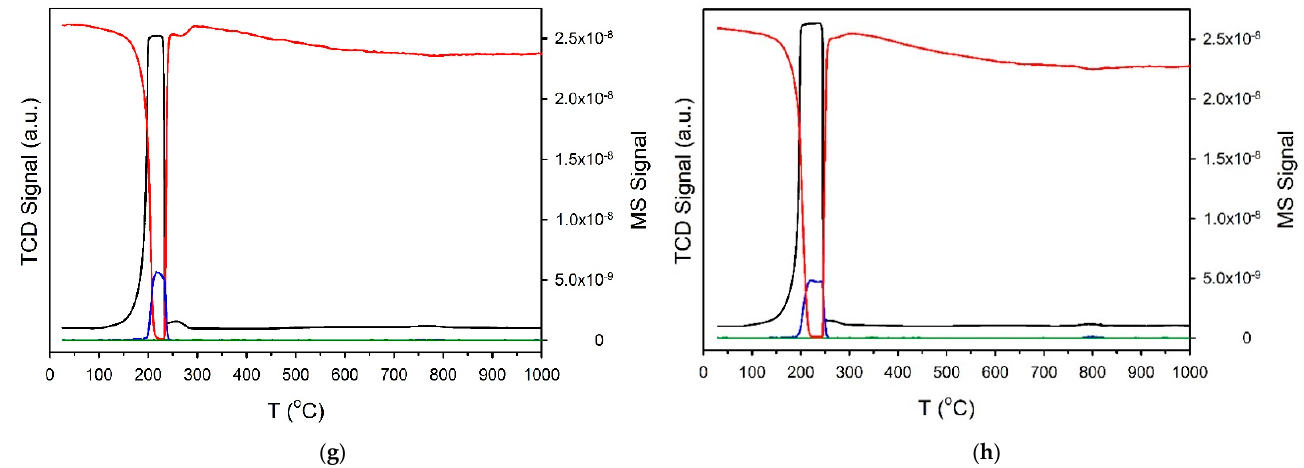
Figure 3. TCD signal (black) and MS signals of (red) H 2 , (blue) CO, and (green) CO 2 during temperature-programmed reduction in 10% H 2 /Ar for ( a ) 2% Pt/ZrO 2 , ( b ) 2.9% Cs-2% Pt/ZrO 2 , ( c ) 3.9% Cs-2% Pt/ZrO 2 , ( d ) 4.8% Cs-2% Pt/ZrO 2 , ( e ) 5.8% Cs-2% Pt/ZrO 2 , ( f ) 7.2% Cs-2% Pt/ZrO 2 , ( g ) 10.4% Cs-2% Pt/ZrO 2 , and ( h ) 14.5% Cs-2% Pt/ZrO 2 (reprinted from [20]).